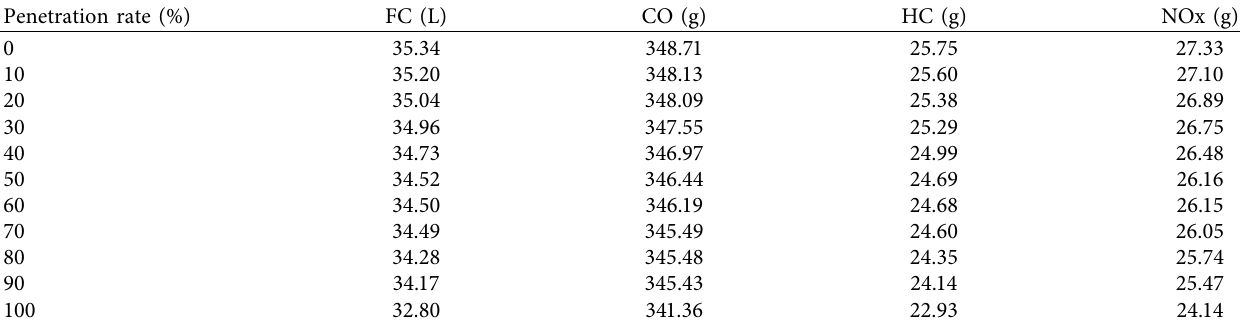
Figure 6: Percentage reduction in fuel consumption and traffic emissions (Scenario 1). Table 5: Fuel consumption and traffic emissions under different penetration rates of CAVs (Scenario 2).